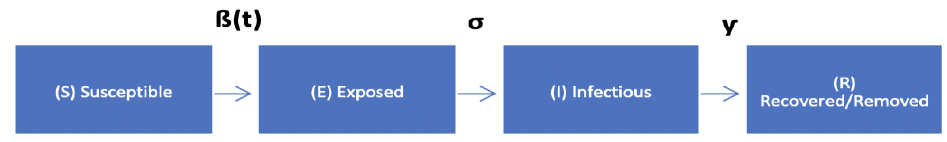
Figure 4. SEIR Model with rate of movement between categories. Table 3. SEIR parameters required to predict the COVID-19 pandemic for Australia. Inputting these variables into the equations will give us the parameters needed to make our predictions using the SEIR model.